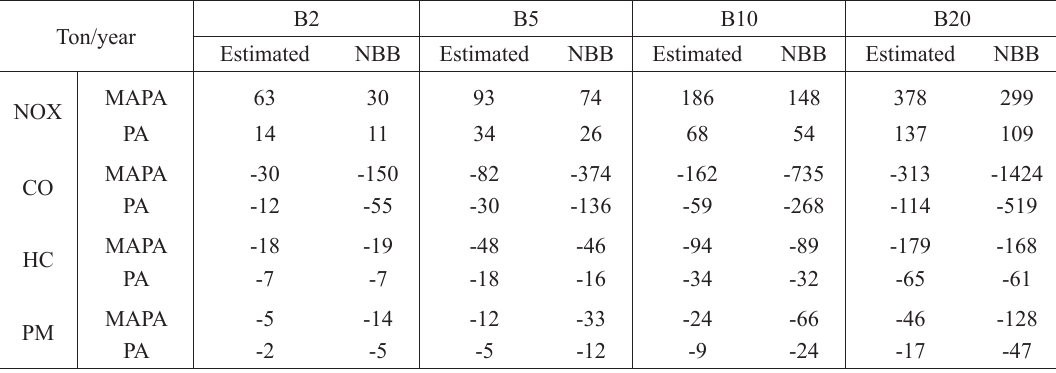
Comparison of the variations on estimated atmospheric emissions of blends of biodiesel in Porto Alegre and the MAPA, with NBB calculation